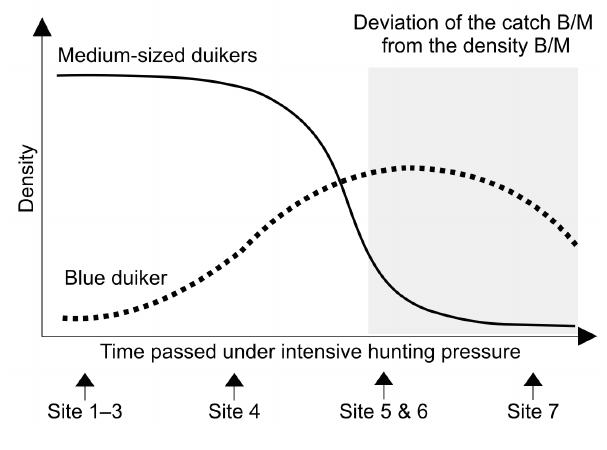
Fig. 3 . Model of changes in the density of blue duikers ( Philantomba monticola ) and medium-sized duikers ( Cephalophus spp.) in accordance with time passed under intensive hunting pressure. Labels of sites 1-7 indicate the approximate situations of these sites. The reasons for the deviations of the ratio of blue to medium-sized duikers for the the text. Density B/M indicates the blue duiker/medium-sized duiker density